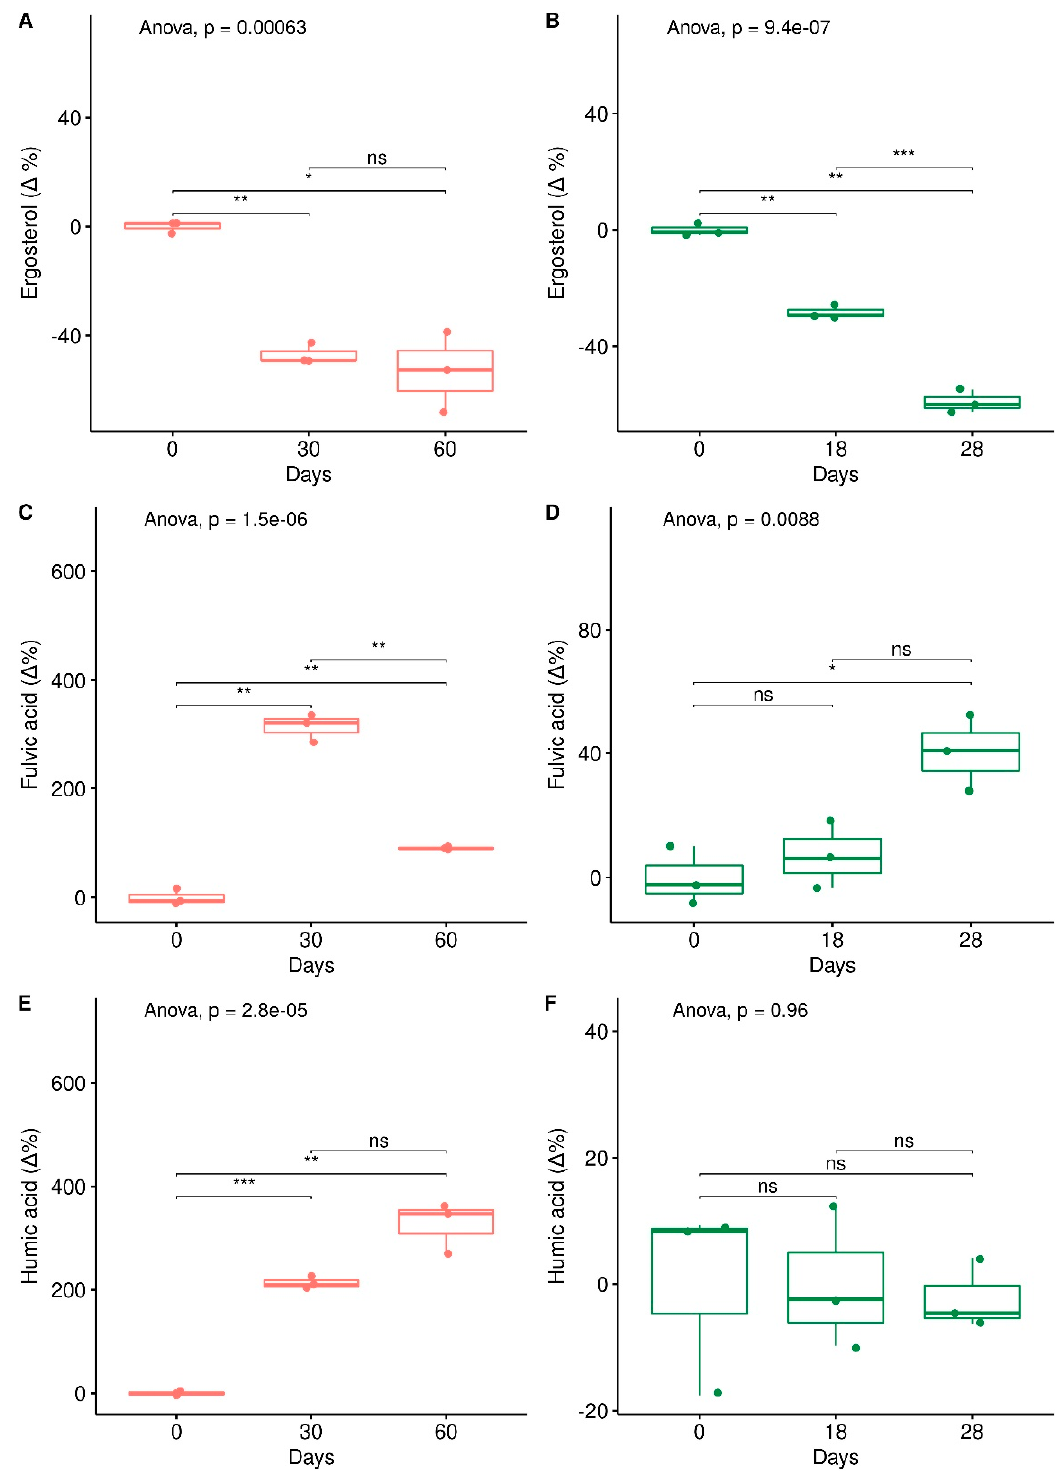
Figure 2. Percentage of variation in other chemical parameters. Reported boxplots represent ergosterol and fulvic and humic acid variations from the start of the bioaugmentation tests in the presence of spent mushroom substrate ( A , C , E ) and Lambertella sp. MUT 5852 ( B , D , F ), expressed as a percentage. Three biological replicates per group are reported. Box and whiskers represent the minimum (Q 0 ), 1st quartile (Q 1 ), median (Q 2 ), 3rd quartile (Q 3 ), and maximum (Q 4 ) of each group. Global statistical significance was tested by one-way ANOVA. Horizontal bars indicate statistical significance of multiple comparisons, calculated by post hoc paired t -tests between group means. Notation for p -value: ns for p > 5 × 10 − 2 ; * for p ≤ 5 × 10 − 2 ; ** for p ≤ 1 × 10 − 2 ; *** for p ≤ 1 × 10 − 3 .